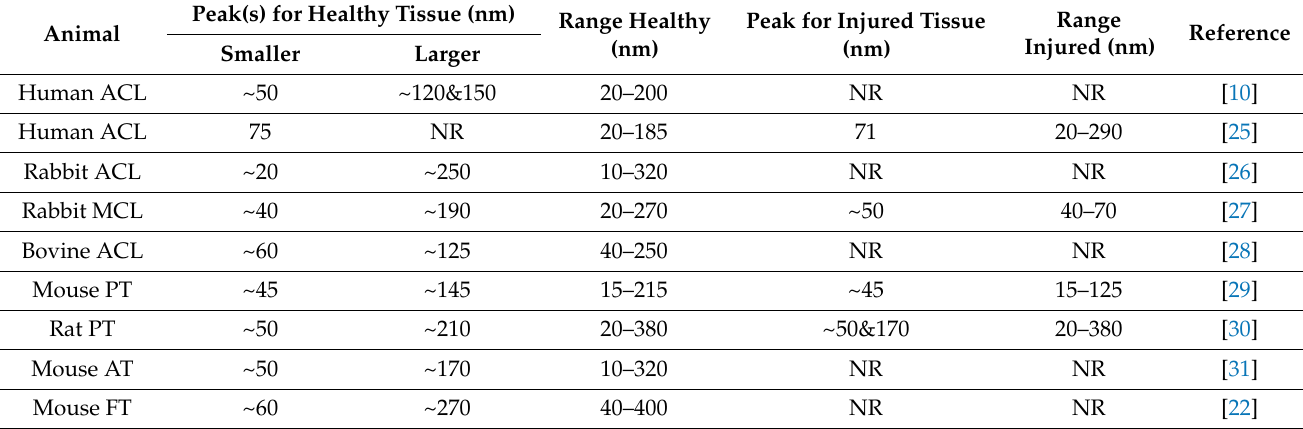
Table 3. Fibril diameter changes of different adult species upon